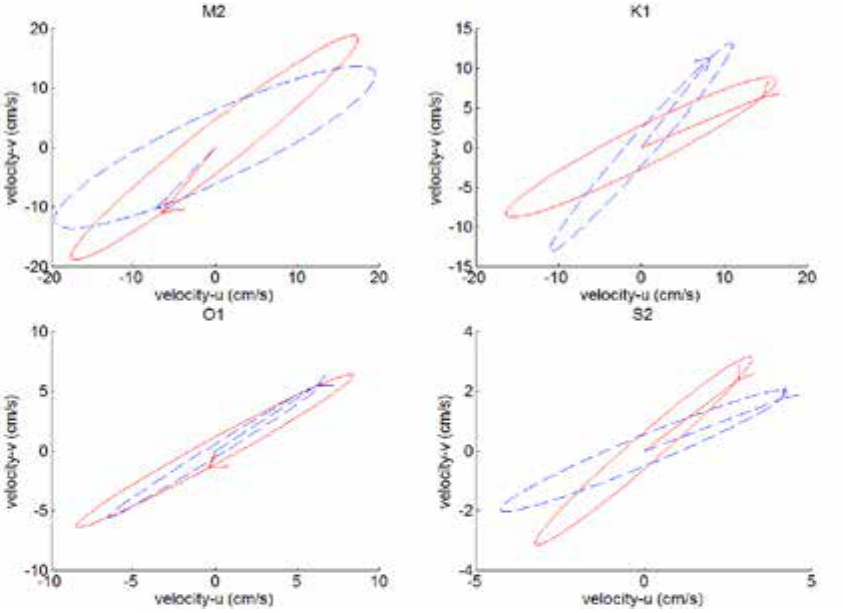
Fig. 6: Comparison between field observations (red) and model (blue) results for M2, O1, K1, S2 tidal currents